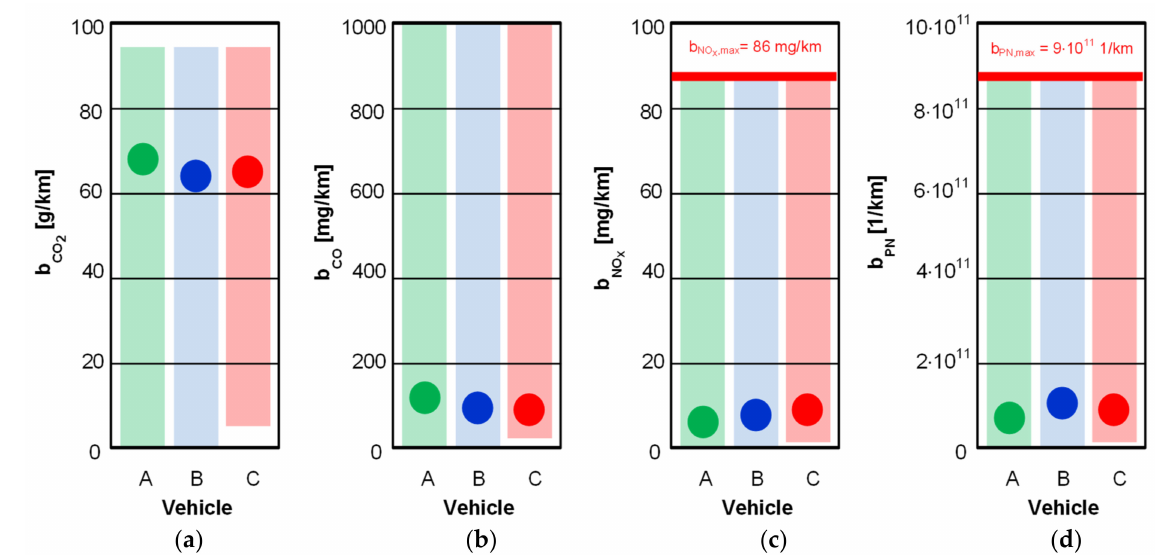
Figure 9. Value of the minimum road emission of carbon dioxide ( a ), carbon monoxide ( b ), nitrogen oxides ( c ), and particle number ( d ) obtained according to the algorithm for variable exhaust emission intensity; data provided in Tables